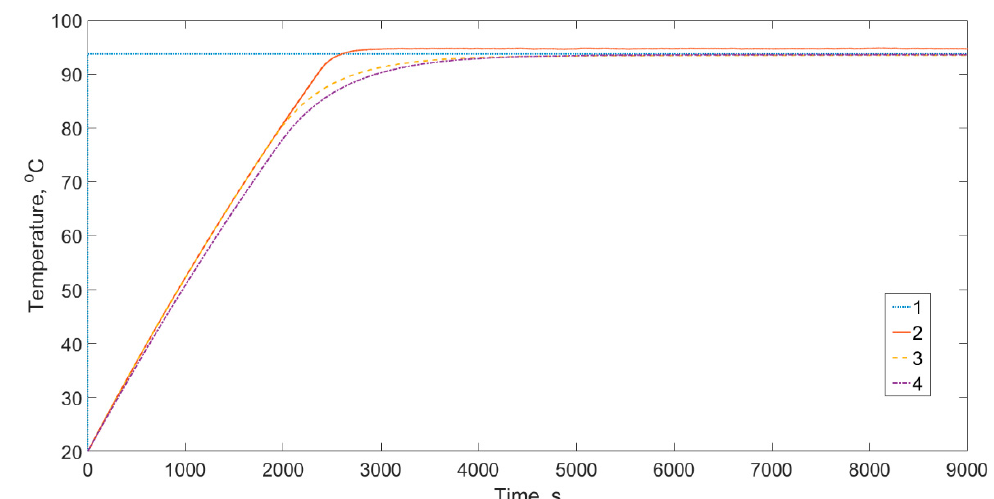
Figure 10. Results of the simulation of control with a random noise signal with a maximum amplitude of 3%: 1—set value of the temperature 2—output signal for a control system with a relay controller, 3—output signal for a control system with a PID controller and 4—output signal for a control system with an I-PD controller.